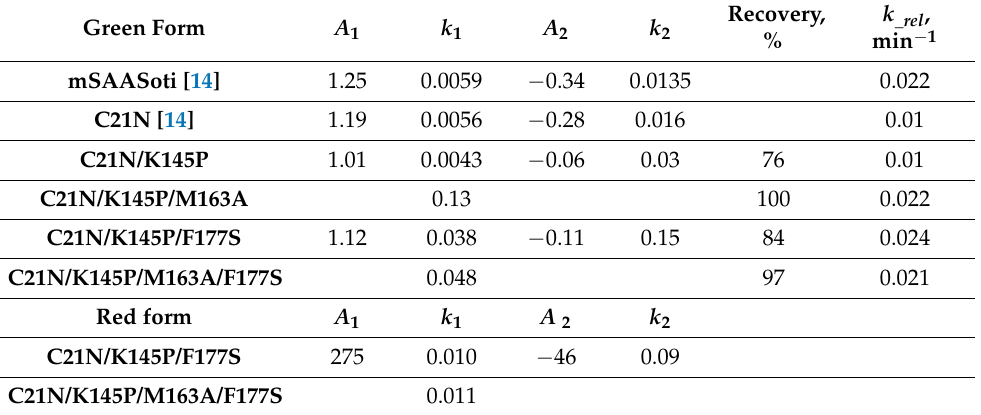
Table 3. Kinetic parameters in the on-to-off photoswitching reaction of the green form measured in 20 mM Tris-HCl, 150 mM NaCl, pH 7.4 buffer, calculated according to Equation (1) for different SAASoti mutant forms; recovery (%) was calculated as the ratio of the absorption after the relaxation and before the switching; k rel corresponds to the reaction of thermal relaxation (off-to-on switching). k _rel , Recovery, Green Form A 1 k 1 A 2 k 2 % min − 1 mSAASoti [14] 1.25 0.0059 − 0.34 0.0135 0.022 C21N [14] 1.19 0.0056 − 0.28 0.016 0.01 C21N/K145P 1.01 0.0043 − 0.06 0.03 76 0.01 C21N/K145P/M163A 0.13 100 0.022 C21N/K145P/F177S 1.12 0.038 − 0.11 0.15 84 0.024 C21N/K145P/M163A/F177S 0.048 97 0.021 Red form A 1 k 1 A 2 k 2 C21N/K145P/F177S 275 0.010 − 46 0.09 C21N/K145P/M163A/F177S 0.011